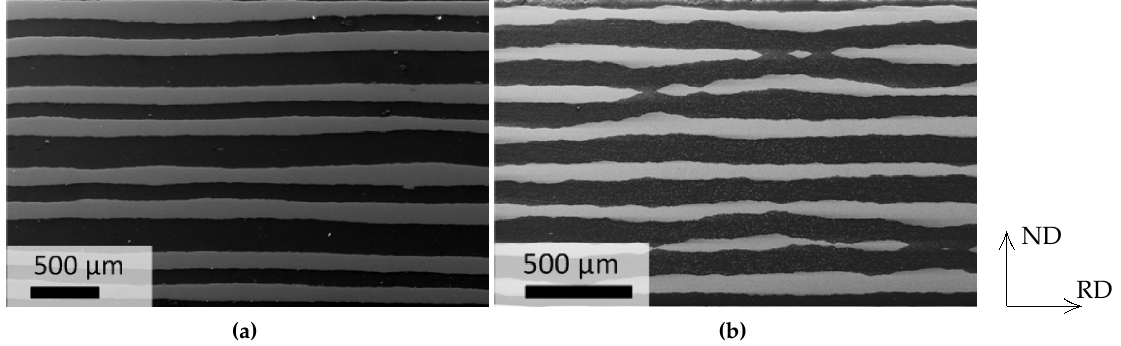
Figure 7. Micrographs showing the longitudinal sections of five-layered composites after four ARB cycles; rolling with a strain rate of 23.4 s − 1 ( a ) and 5.3 s − 1 ( b ).